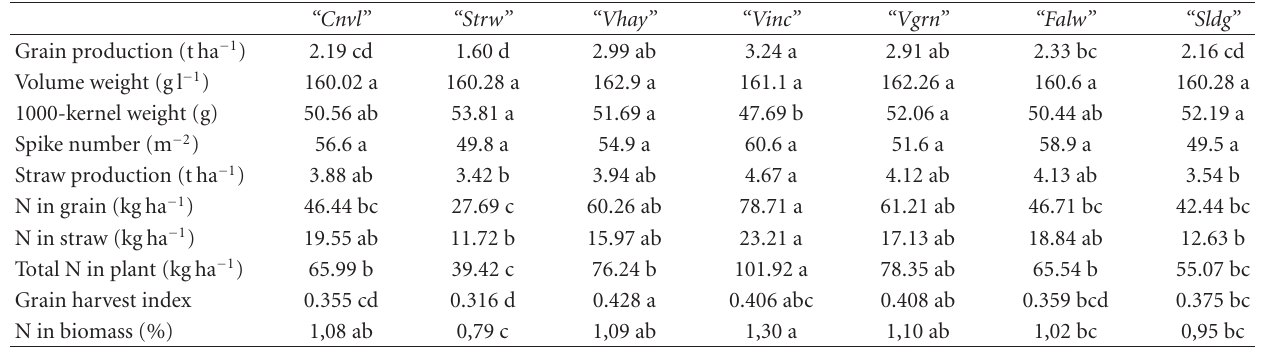
Table 3: Mean values of grain and straw yields, grain yield components, grain quality characteristics, and N concentrations in the plant parts harvested after the second year of experimentation. Values followed by the same letter do not show statistically significant di ff erences between treatments at P < 0 . 05.